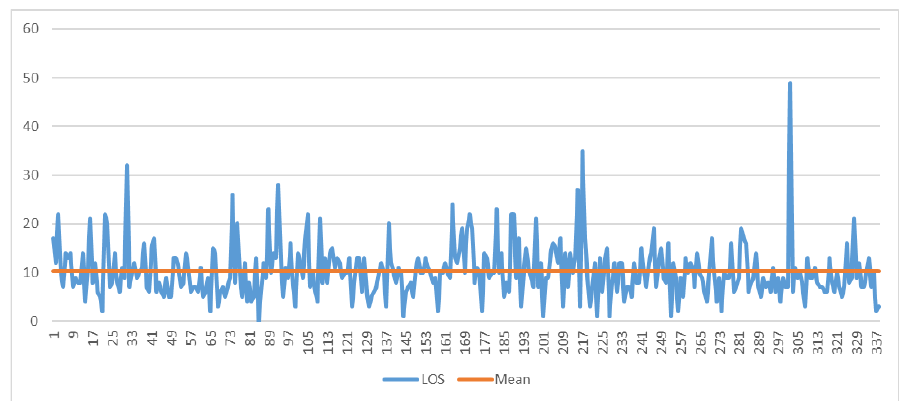
Figure 11. A run chart of total LOS for stroke patients during the COVID-19 pandemic. The orange line indicates the average value of 10.27 days.